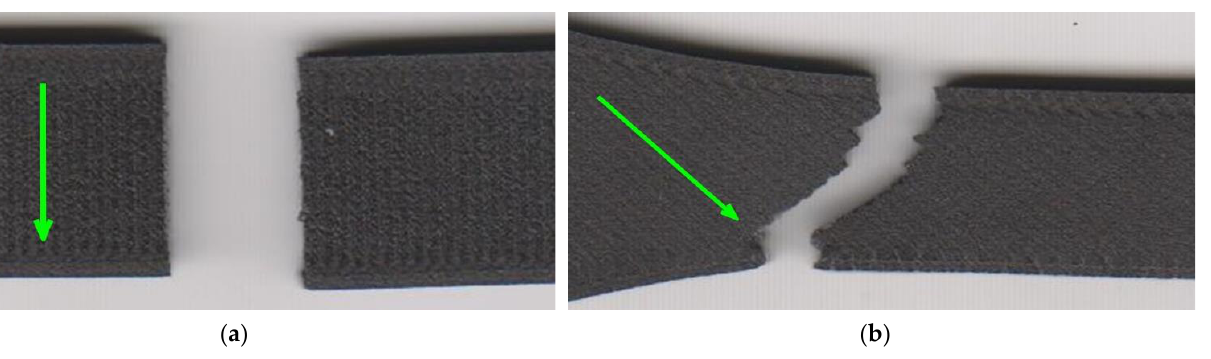
Figure 13 . Detail of fracture: ( a ) 0/90 infill strategy; ( b ) 45/ − 45 infill strategy. Green arrows present − 45 infill strategy. Green arrows present the orientation of the solid infill in the top layer. Figure 13. Detail of fracture: ( a ) 0/90 infill strategy; ( b ) 45/ the orientation of the solid infill in the top